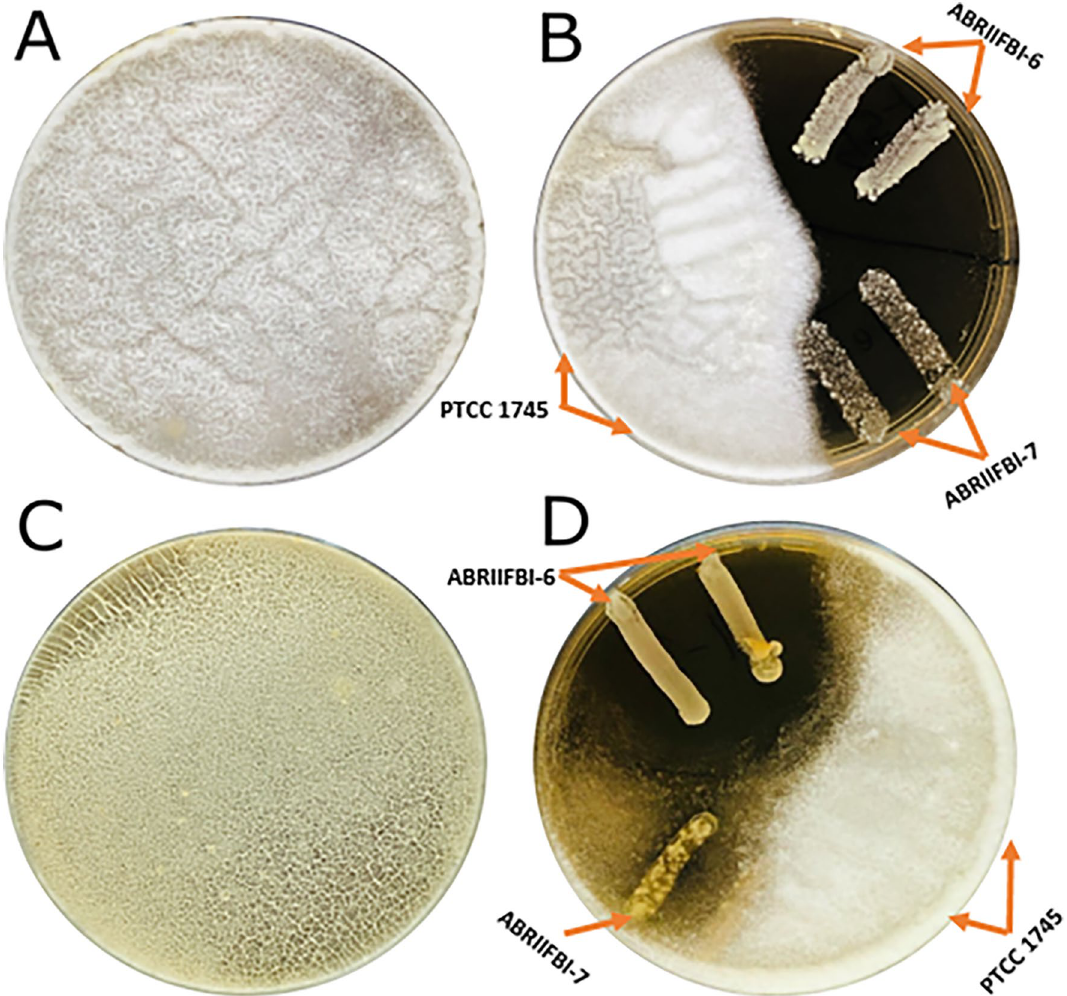
Figure 1. Antifungal activity of potential probiotic strains against Aspergillus flavus and Aspergillus niger is shown in Figure. ( A ) A. flavus covered the entire plate in the absence of probiotics. ( B ) The potential probiotics ABRIIFBI-6 and ABRIIFBI-7 were able to inhibit the growth of A. flavus , whereas PTCC 1745, used as a control, was unable to do so. ( C ) A. niger covered the entire plate in the absence of probiotics. ( D ) The potential probiotic ABRIIFBI-6 was able to inhibit the growth of A. niger similarly to A. flavus , but ABRIIFBI-7 only slightly inhibit the growth of A. niger . Furthermore, strain PTCC 1745, used as a control, was unable to inhibit the growth of both aspergilli.